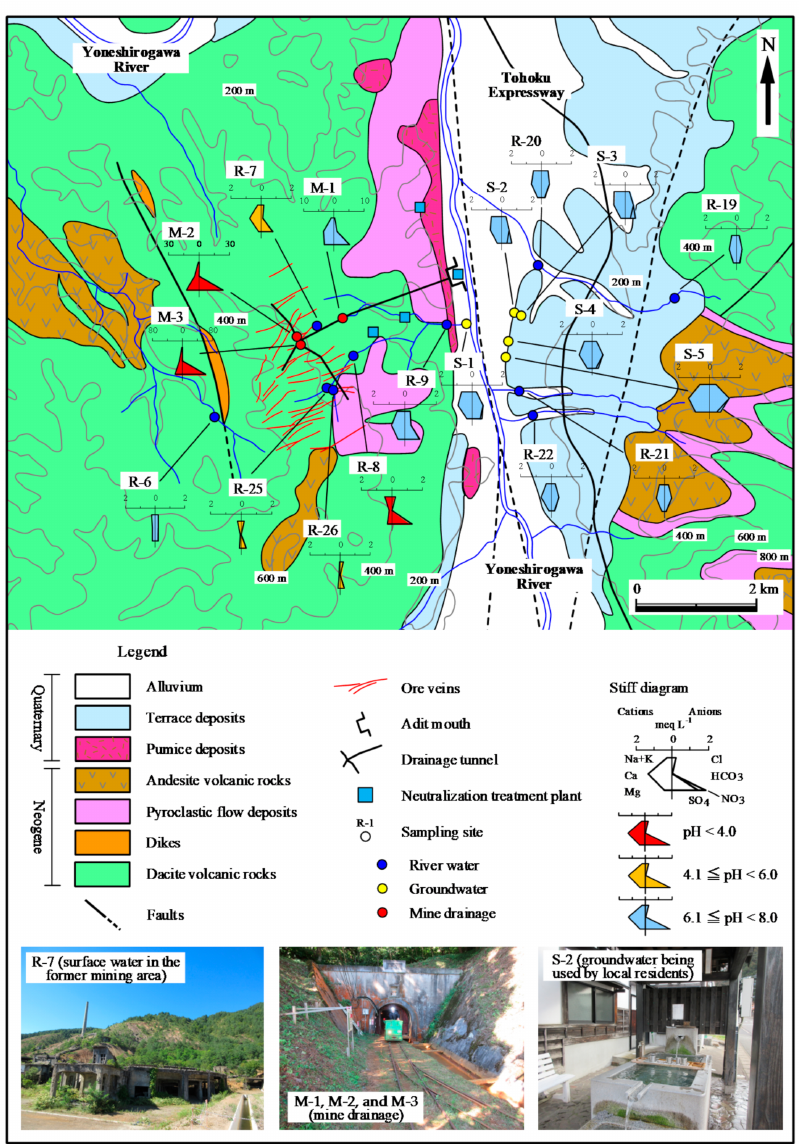
Figure 2. Geological map and locations of water sampling sites, with corresponding water sample properties indicated by Stiff